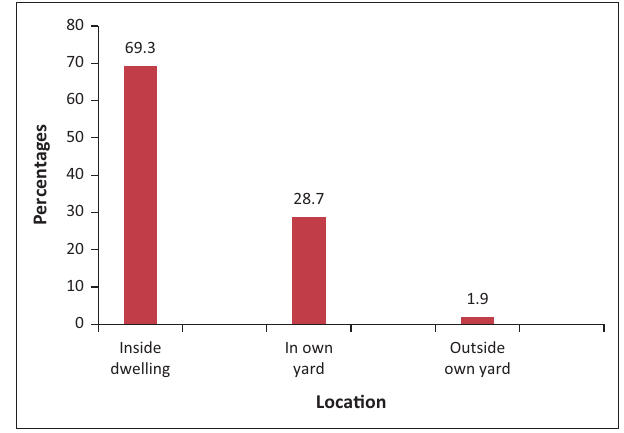
FIGURE 3: Households with access to flush toilets by location